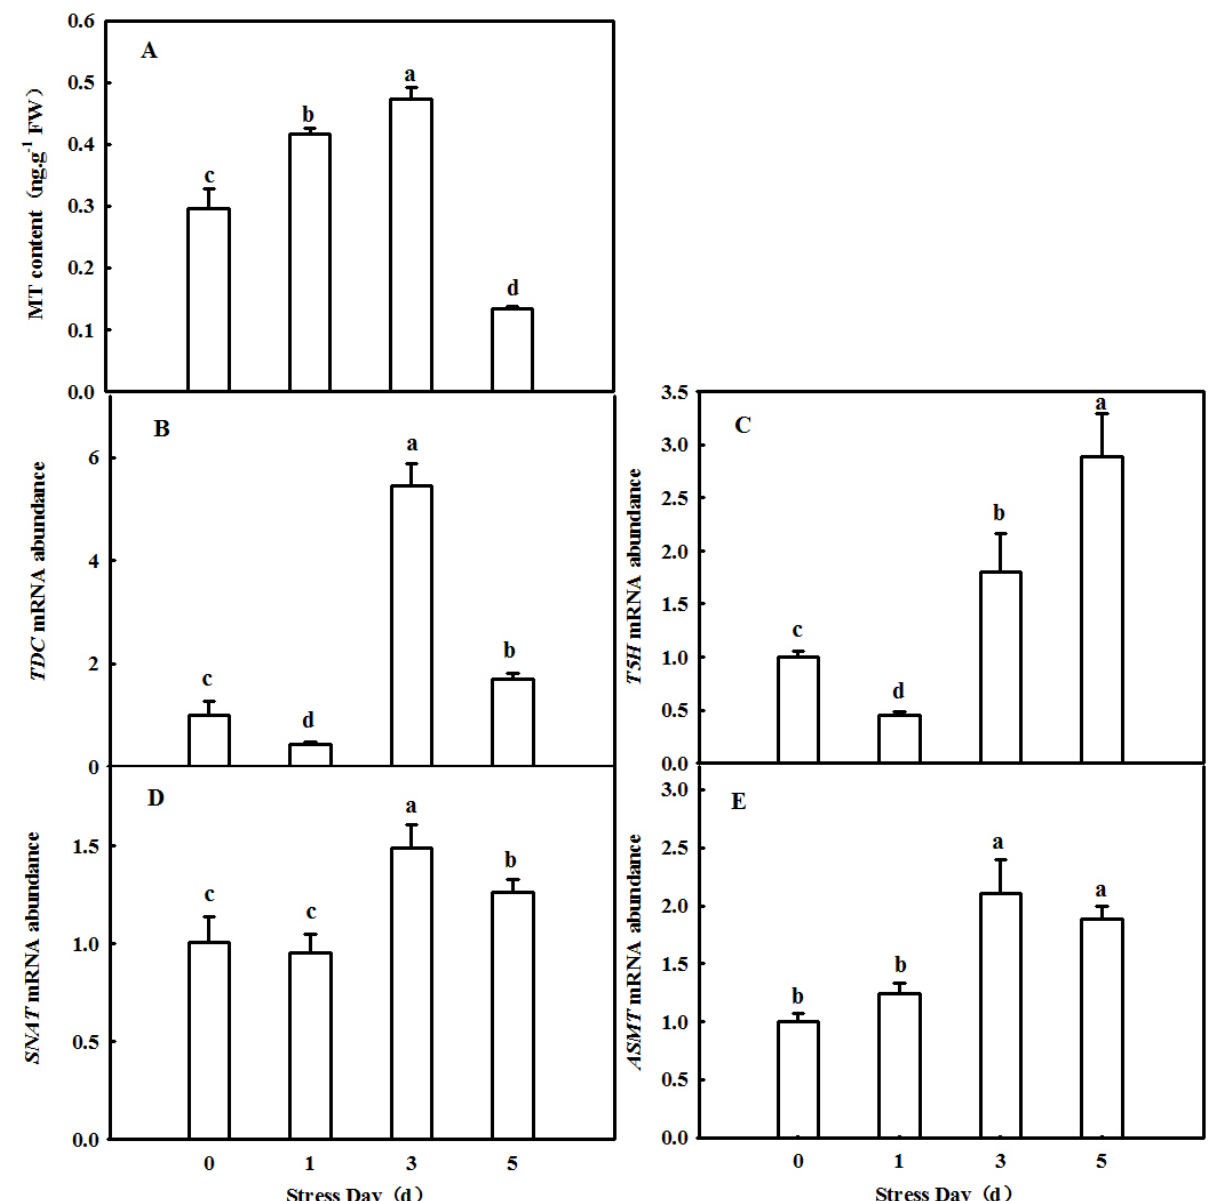
Figure 1. The variation of endogenous MT ( A ) and mRNA expression of TDC ( B ), T5H ( C ), SNAT ( D ), and ASMT ( E ) in leaves of cucumber plants under darkness. The two-leaf stage cucumber seedlings were treated with dark condition (day/night temperature: 25 ◦ C/18 ◦ C). The 2nd leaf samples were taken at 0, 1, 3, and 5 days. All values shown are mean ± SD ( n = 3). a–d indicate that mean values are significantly different among samples ( p < 0.05).